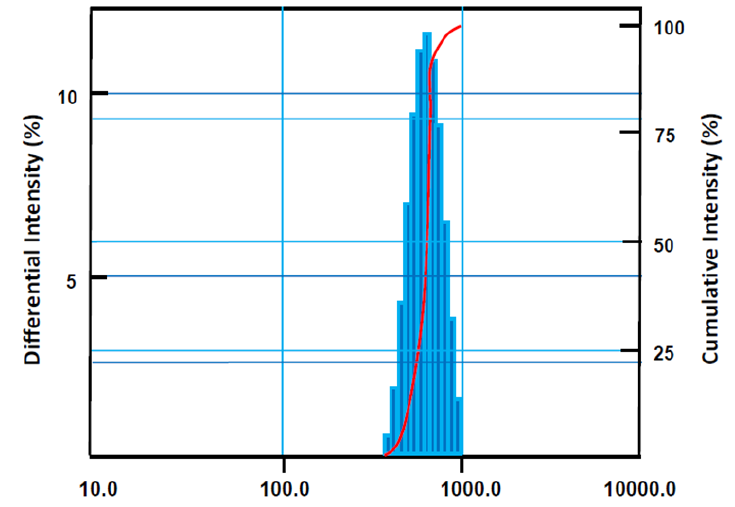
Figure 4. Histogram of the particle size distribution and accumulated fraction of OMMT nanoparticles.